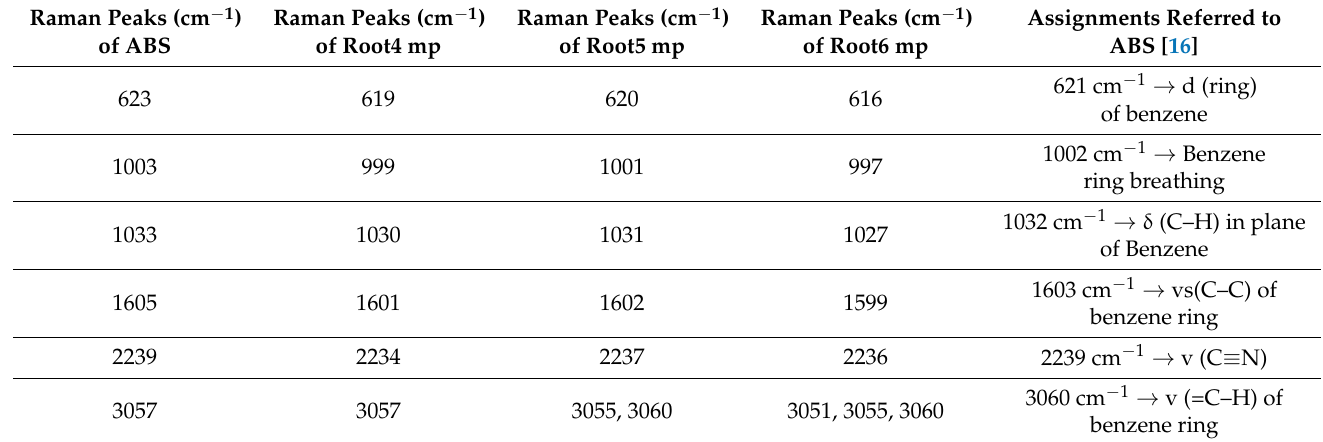
Table 3. Raman peaks of ABS and MPs with their assignments.